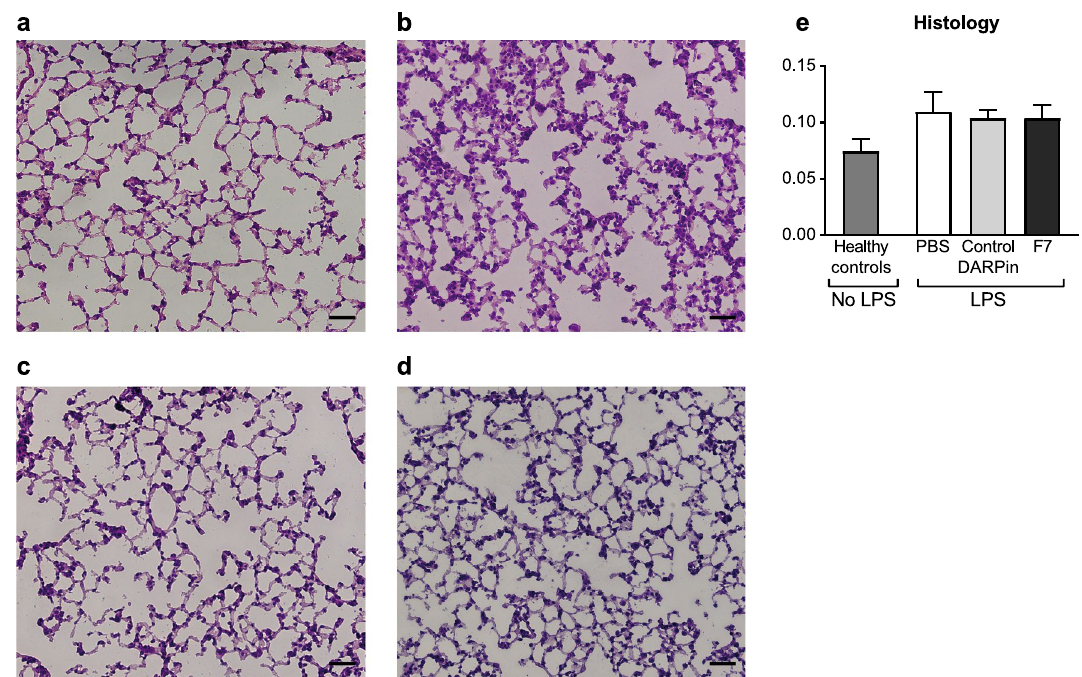
Figure 8. Histological analysis of lung sections during the chronic phase on day 10 reveals no significant differences between treatment groups. Representative histological sections of mice in the different treatment groups stained with hematoxylin–eosin: ( a ) Healthy controls, ( b ) PBS, ( c ) control DARPin, ( d ) F7. The scale bar indicates 50 µm. ( e ) The lung injury scoring system according to Matute Bello et al. was used for histological analysis and is described in the “Methods” section. The histological score of the group treated with F7 was not significantly different from the PBS or control DARPin treated group indicating reduced histological signs of inflammation. Data are presented as mean ± SEM. n = 5–10. Treatment groups were compared by an unpaired t-test. The scale bar represents 50